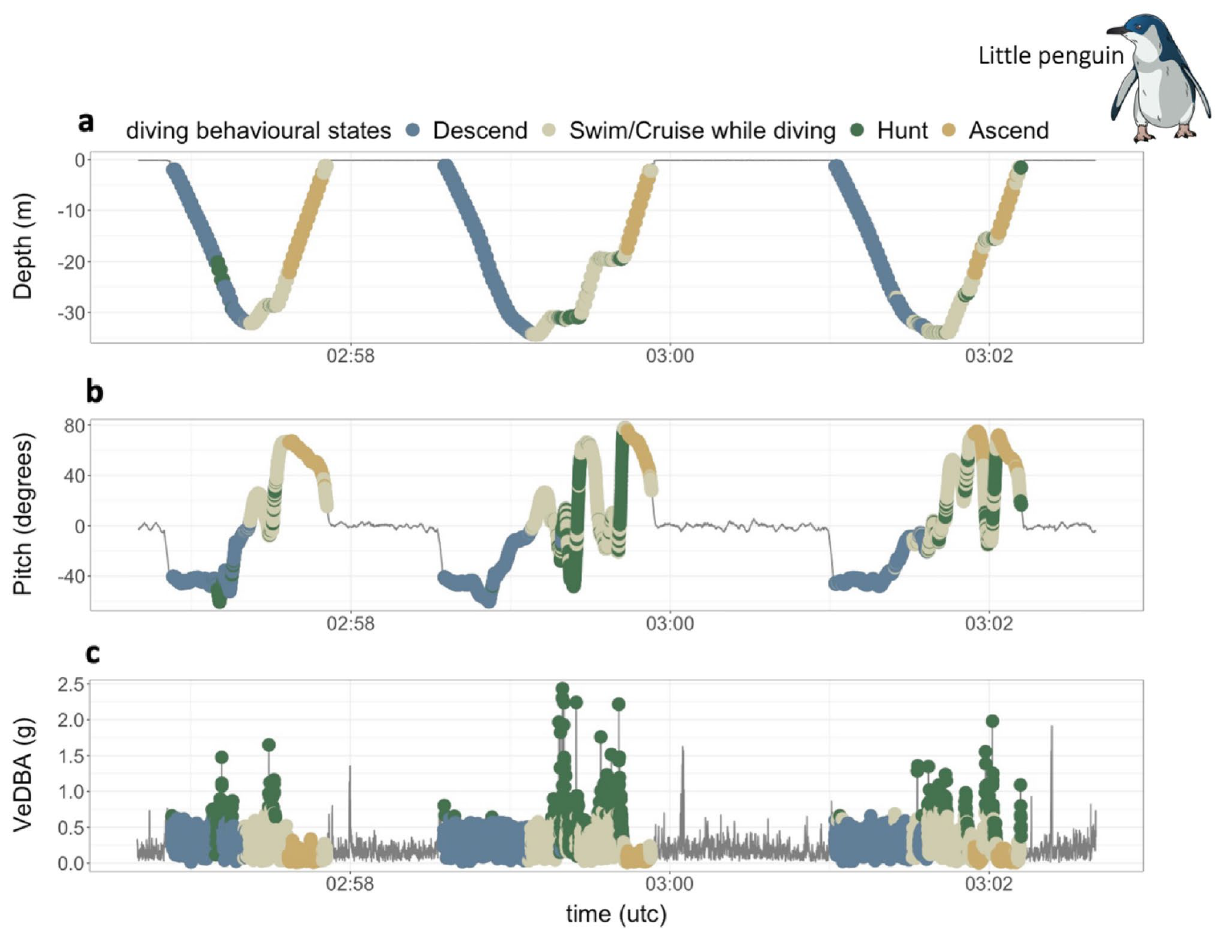
Figure 3. Example of behavioural classification in Little penguins ( Eudyptula minor ) while diving. ( a ) diving profiles, ( b ) Pitch (degrees) indicating body posture while diving, ( c ) Vectorial Dynamic Body Acceleration (VeDBA, g) indicating overall acceleration while moving underwater. Colours indicate the behavioural states identified while